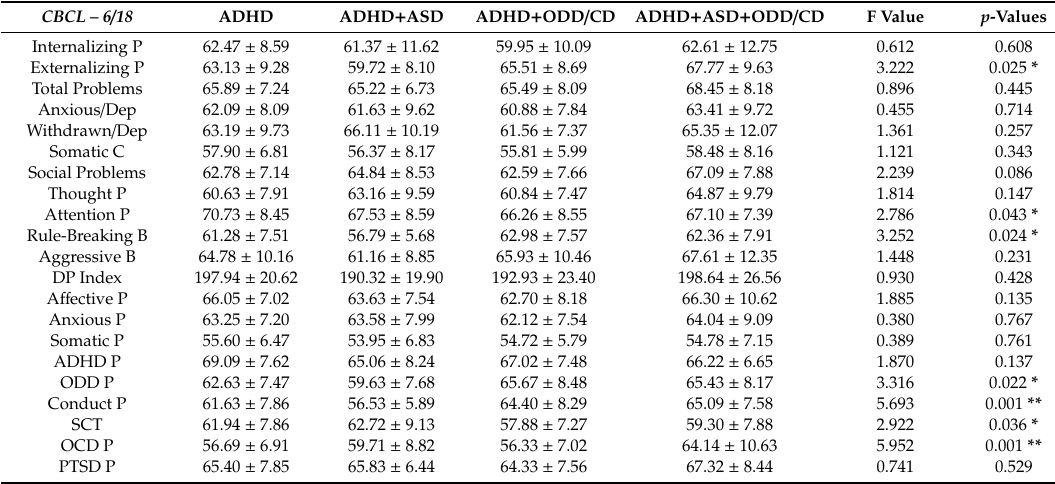
Table 2. CBCL-6 / 18